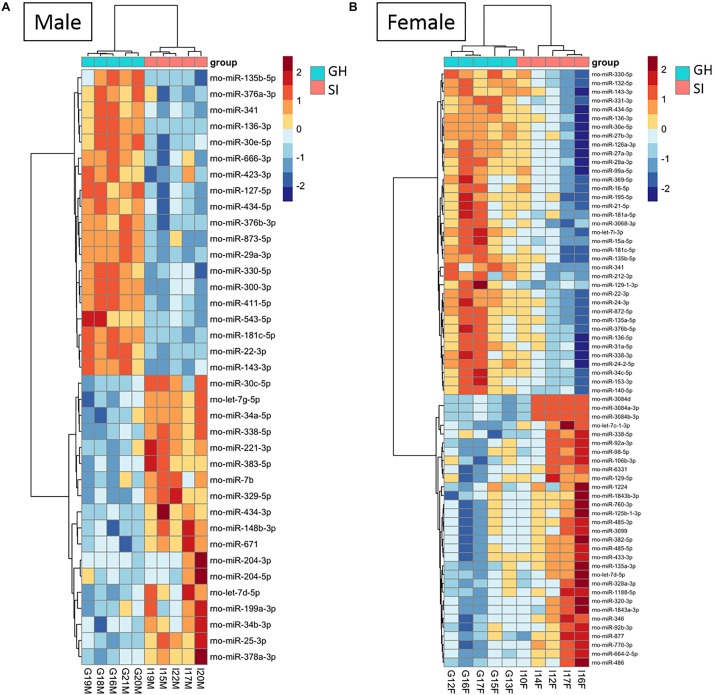
Housing condition during adolescence induces sex-specific miRNA expression in the anterodorsal bed nucleus of the stria terminalis (adBNST) in adulthood. Color represents the miRNA z-score expression. The median of the expression is used for each group. DE miRNAs between SI and GH in (A) males and (B) females; n = 5/group; GH, group housed; SI, socially isolated.